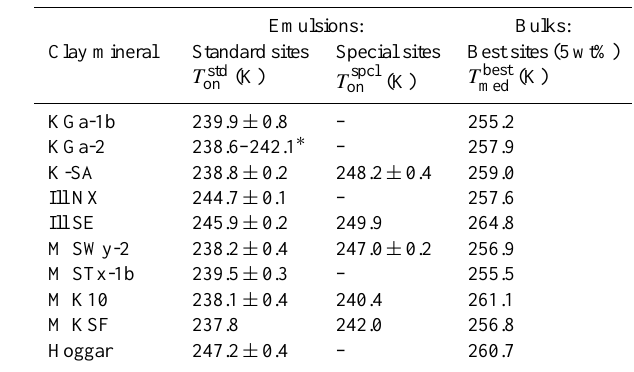
Table 2. Summary of freezing peaks of emulsion and bulk experi- ments: onset freezing temperatures are given for standard and spe- cial sites, average of median freezing temperatures for best sites (5wt% suspension concentration). Where the standard deviation is not shown, there were too few data for